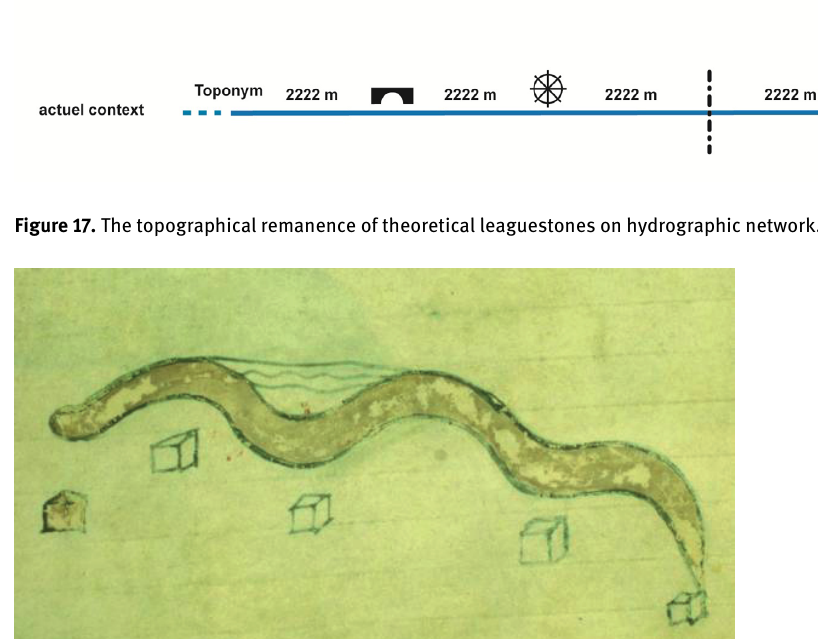
Figure 18. Ancient river landmarking as a testimony from the Gudianus manuscript (fig. 58 Th ou 61 La ; Ms Gudianus). © Herzog August Bibliothek,